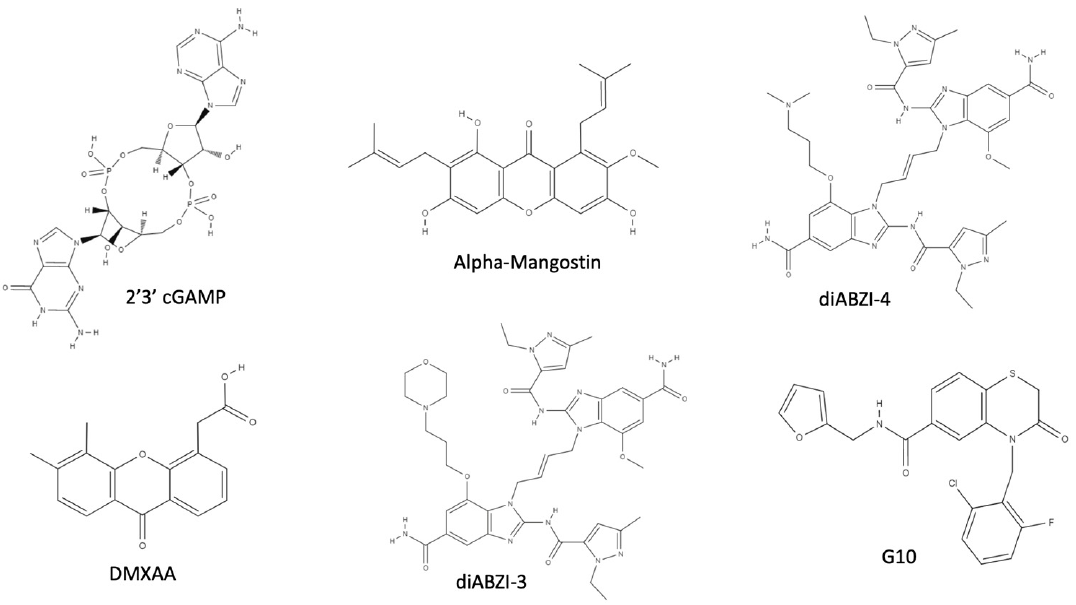
Figure 7. Chemical structure of STING agonists. 2 ′ 3 ′ cGAMP; DMXAA; alpha-Mangostin; diABZI- 3;